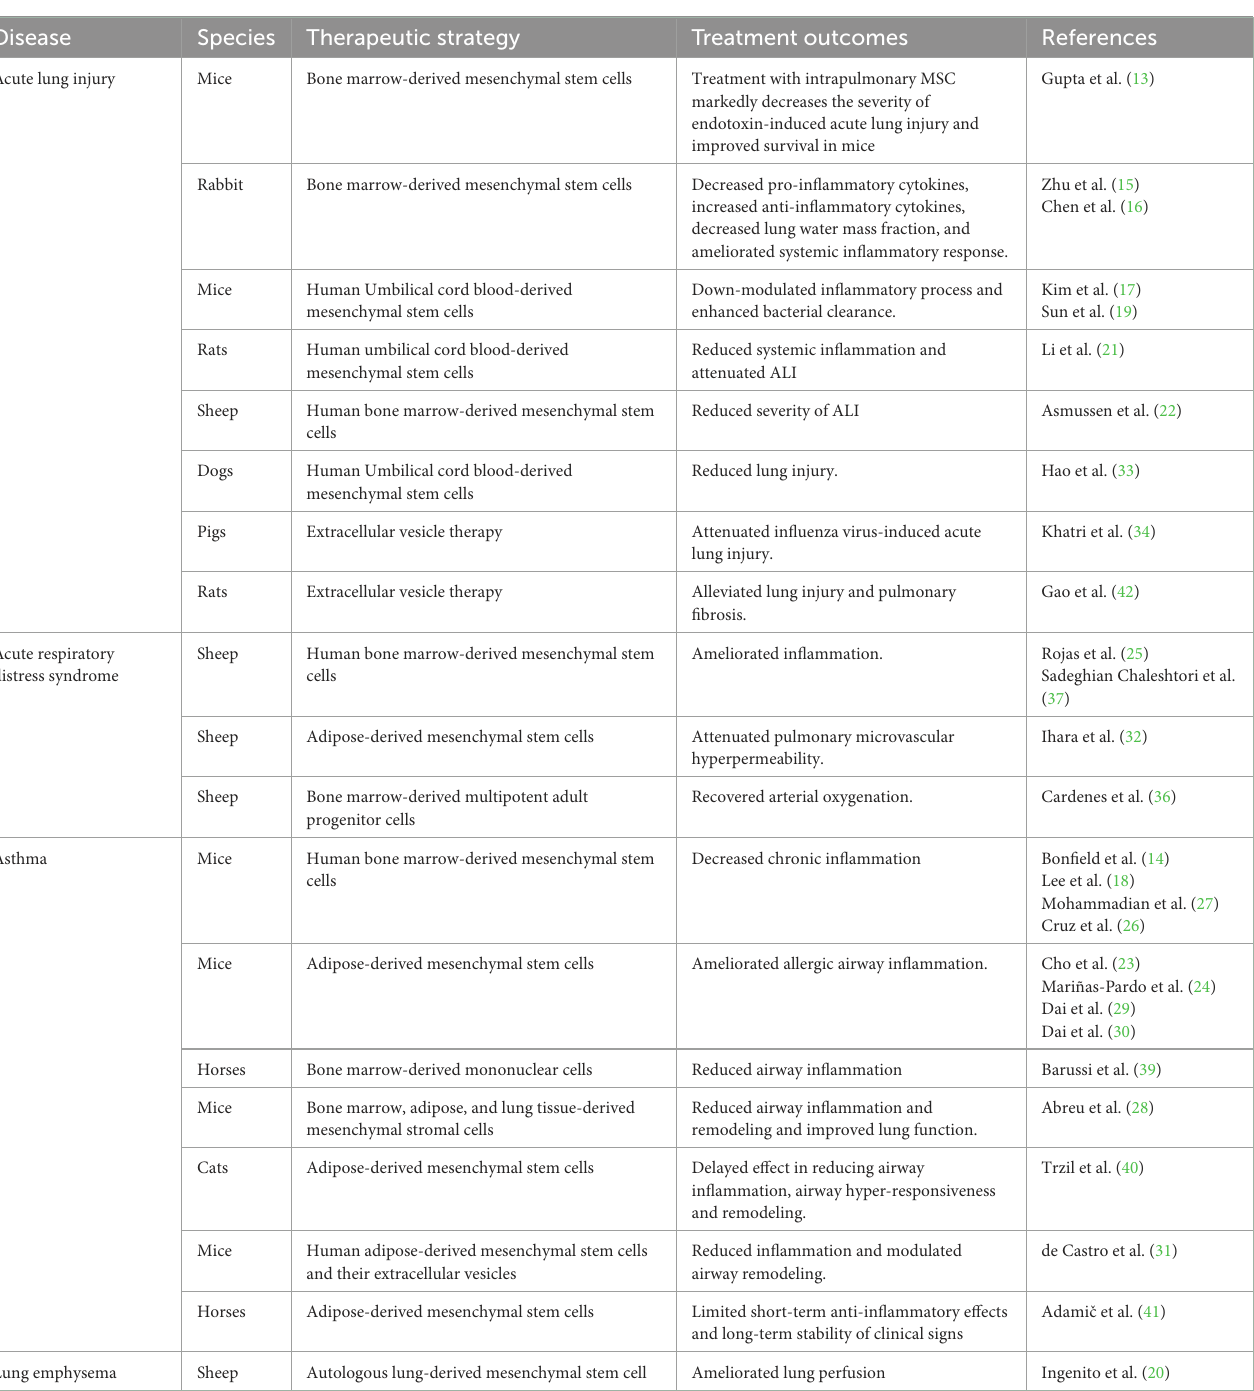
TABLE 1 List of selected references reporting the use of regenerative treatments for respiratory diseases in animals.